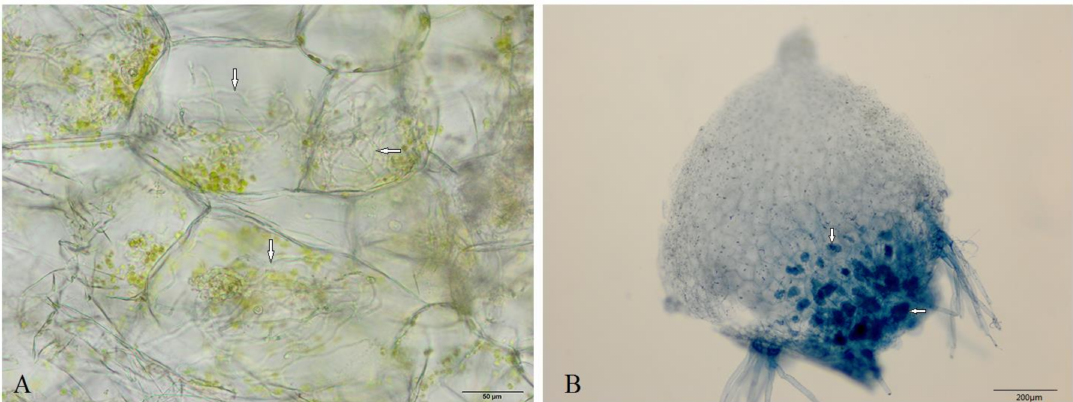
Figure 1. The morphological observation of intracellular hyphae in the symbiotic germinated seeds of D. officinale . The microscopic observation of intracellular hyphae in a free-hand section ( A ) of germinated seeds were stained blue following Trypan blue staining ( B ). The arrows indicate the symbiotic